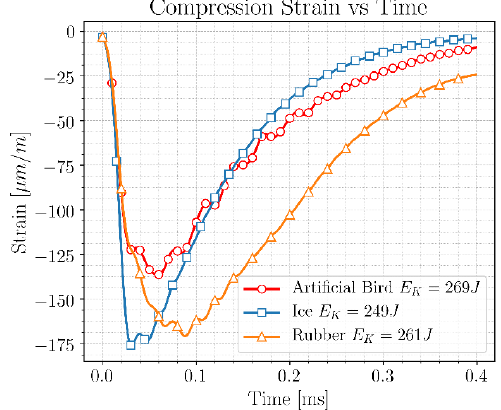
Figure 1: Ice, Artificial Bird and Natural Rubber spheres impact at similar kinetic energies.